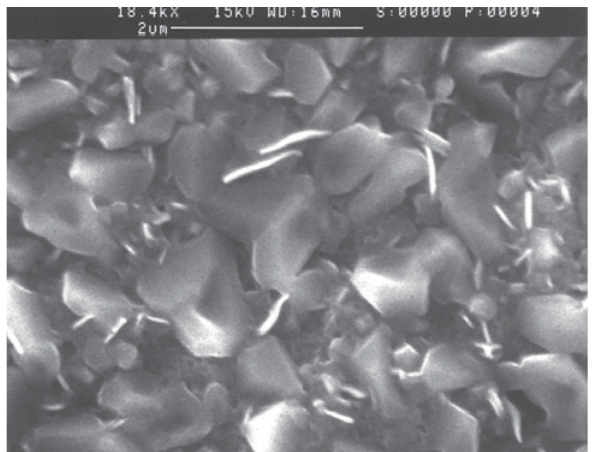
Figure 6. Observation of the surface of the oxidized 439 steel af- ter 50h at 850 °C in Ar-H -H O mixture (18400×). 2 2